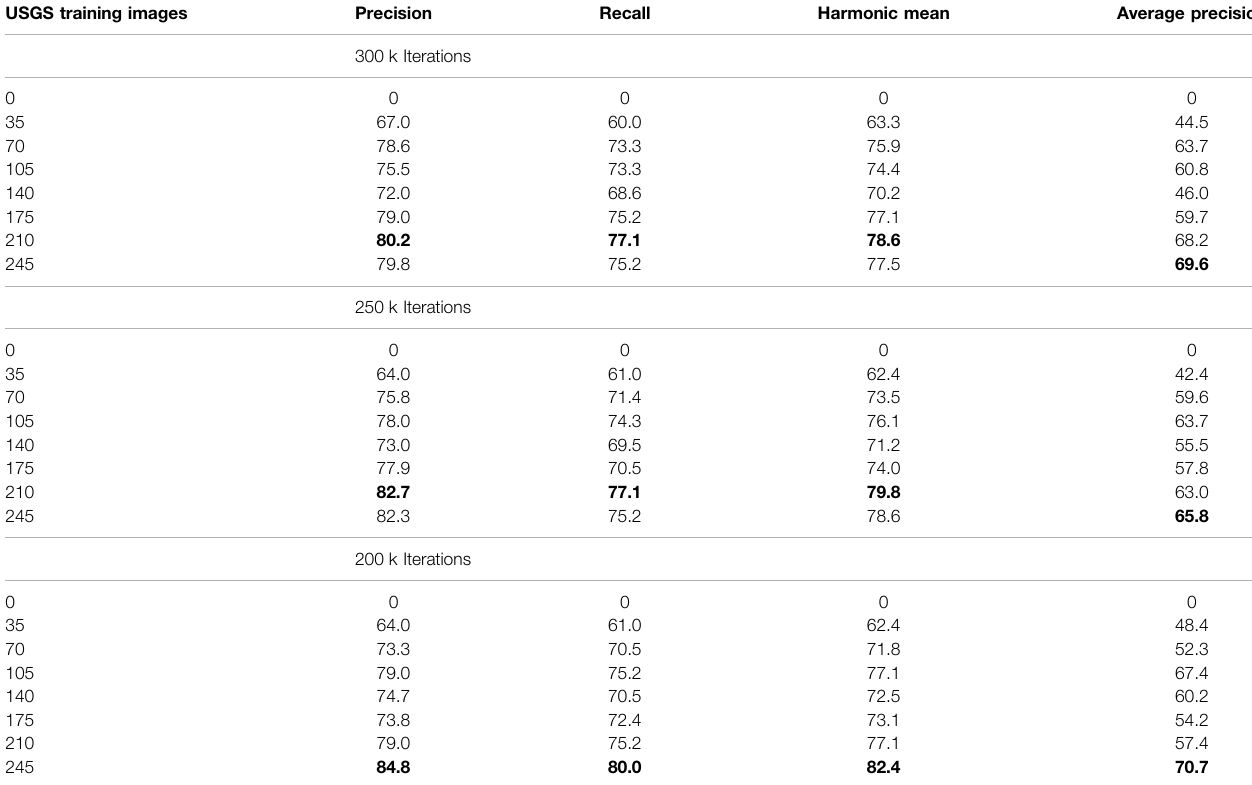
TABLE 4 | Metrics describing classi fi cation results of detection/recognition work fl ow by incrementally increasing the number of custom training images by 35, and by decreasing the number of total training iterations by 50 k intervals. Bold text indicates the best performance in the set of tests with that model. USGS training